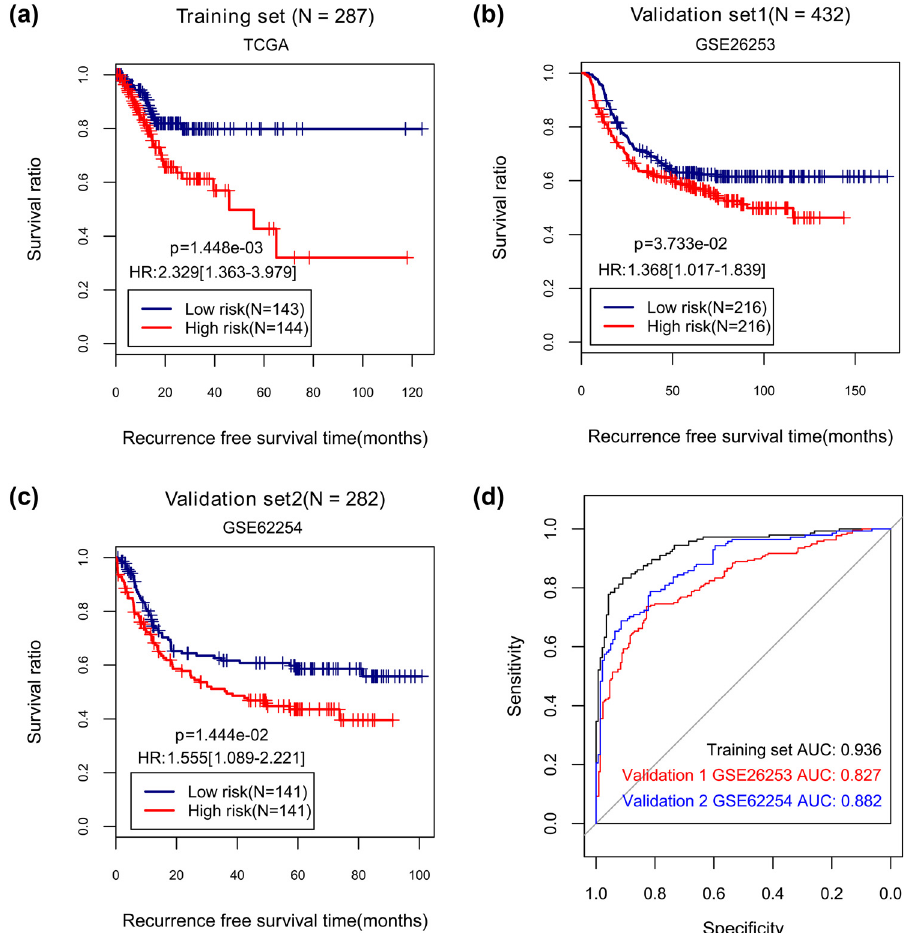
Figure 4: Kaplan – Meier estimates of recurrence - free survival and ROC curves for patients in training set and two validation sets by the four - lncRNA signature. ( a – c ) Kaplan – Meier curves for training set, validation set 1, and validation set 2. ( d ) ROC curves and AUC values of three data